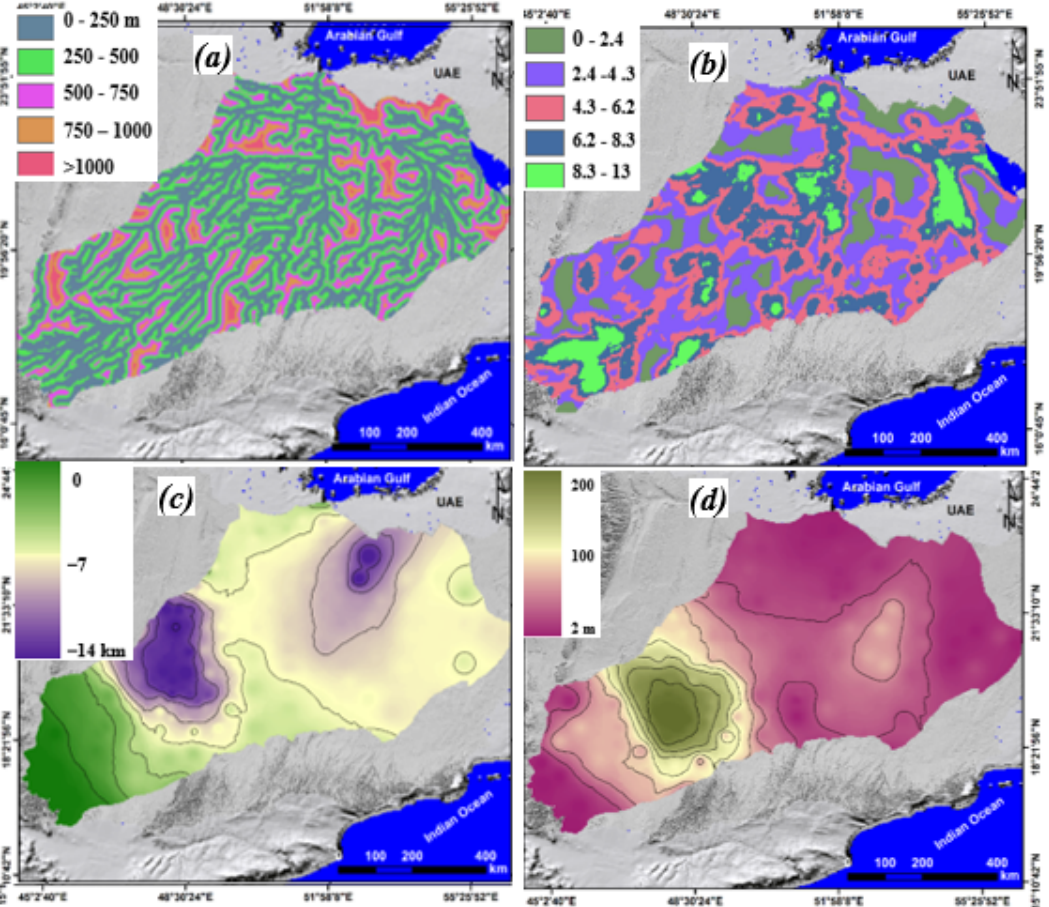
Figure 6. Maps of altitude ( a ), aspect ( b ), slope ( c ) fault density ( d ), distance from faults ( e ), and zones of flow accumulation for the ARAK.